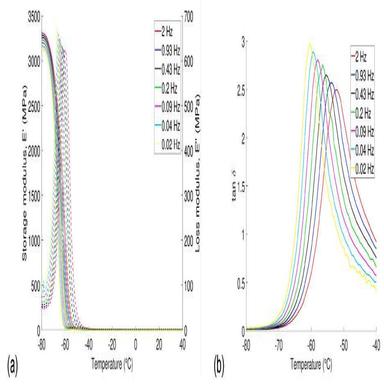
DMA results for F-NR2: (a) temperature dependent storage (solid line) and loss (dashed line) moduli and (b) loss tangents.